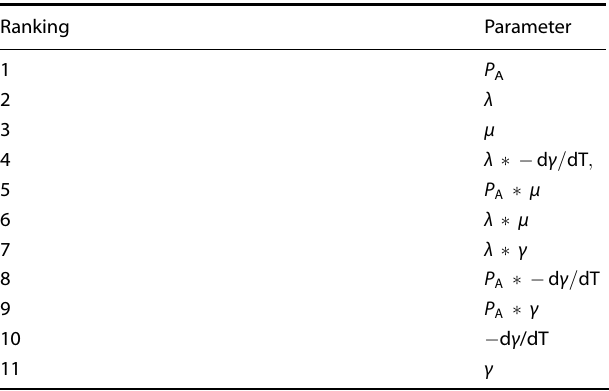
Table 3. Parameter ranking of main effects and 2-factor interactions in the best subset